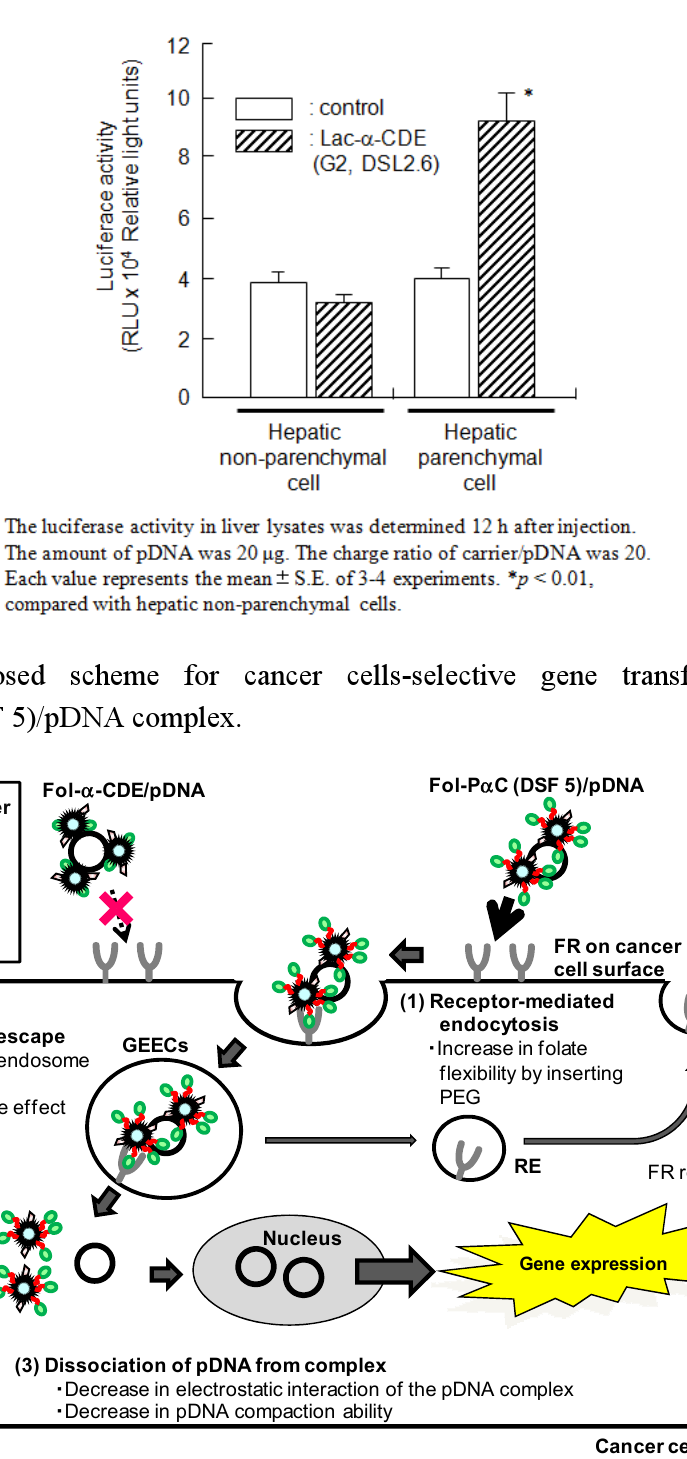
Figure 8. Luciferase activity in hepatic non-parenchymal cells or hepatic parenchymal cells 12 h after intravenous administration of the pDNA complexes with Lac- α -CDE (G2, DSL 2.6).